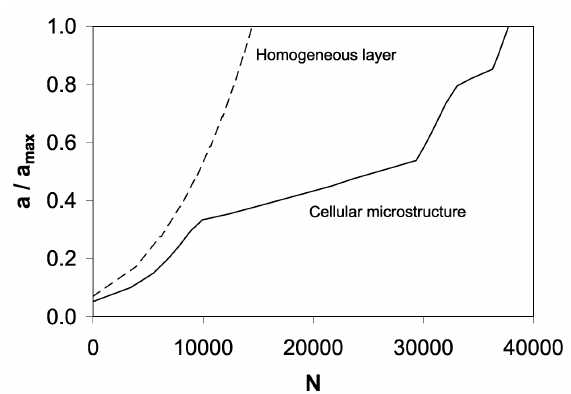
Figure 9. Dimensionless crack length vs. loading cycles. The response of a cellular microstructure is compared with that of a homogeneous PCD